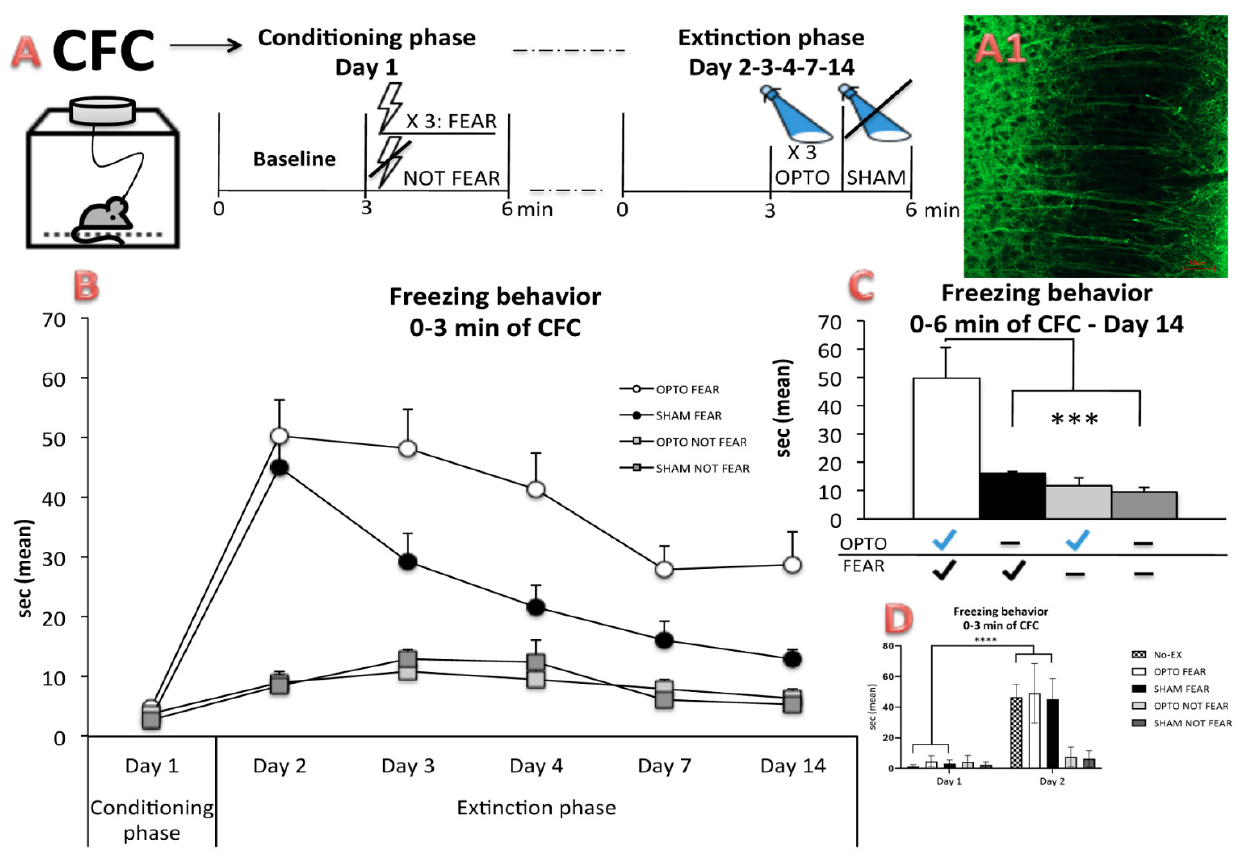
Figure 1. Experimental procedures and behavioral results of in vivo optogenetics of the Prelimbic (PrL) pyramidal neurons during Contextual Fear Conditioning (CFC). ( A ) On day 1 (Conditioning phase) of CFC, each Thy1-COP4 mouse was allowed to explore the conditioning chamber for 3 min (Baseline). Afterward, only a part of the entire sample received three foot-shocks. On days 2, 3, 4, 7, and 14 (Extinction phase), the fear-conditioned ( n = 20) and not fear-conditioned ( n = 20) mice were placed again in the conditioning chamber for 6 min. During the Extinction phase, no shock was delivered and the mice received three optogenetic (OPTO FEAR and OPTO NOT FEAR groups, n = 10/group) or sham (SHAM FEAR and SHAM NOT FEAR groups, n = 10/group) stimulations of PrL pyramidal neurons. To control for the effects of learned but not yet extinguished fear, on day 1 (Conditioning phase) of CFC other Thy1-COP4 mice (No-EX group, n = 6) were allowed to explore the conditioning chamber for 3 min (Baseline) and then they received three foot-shocks. The day after